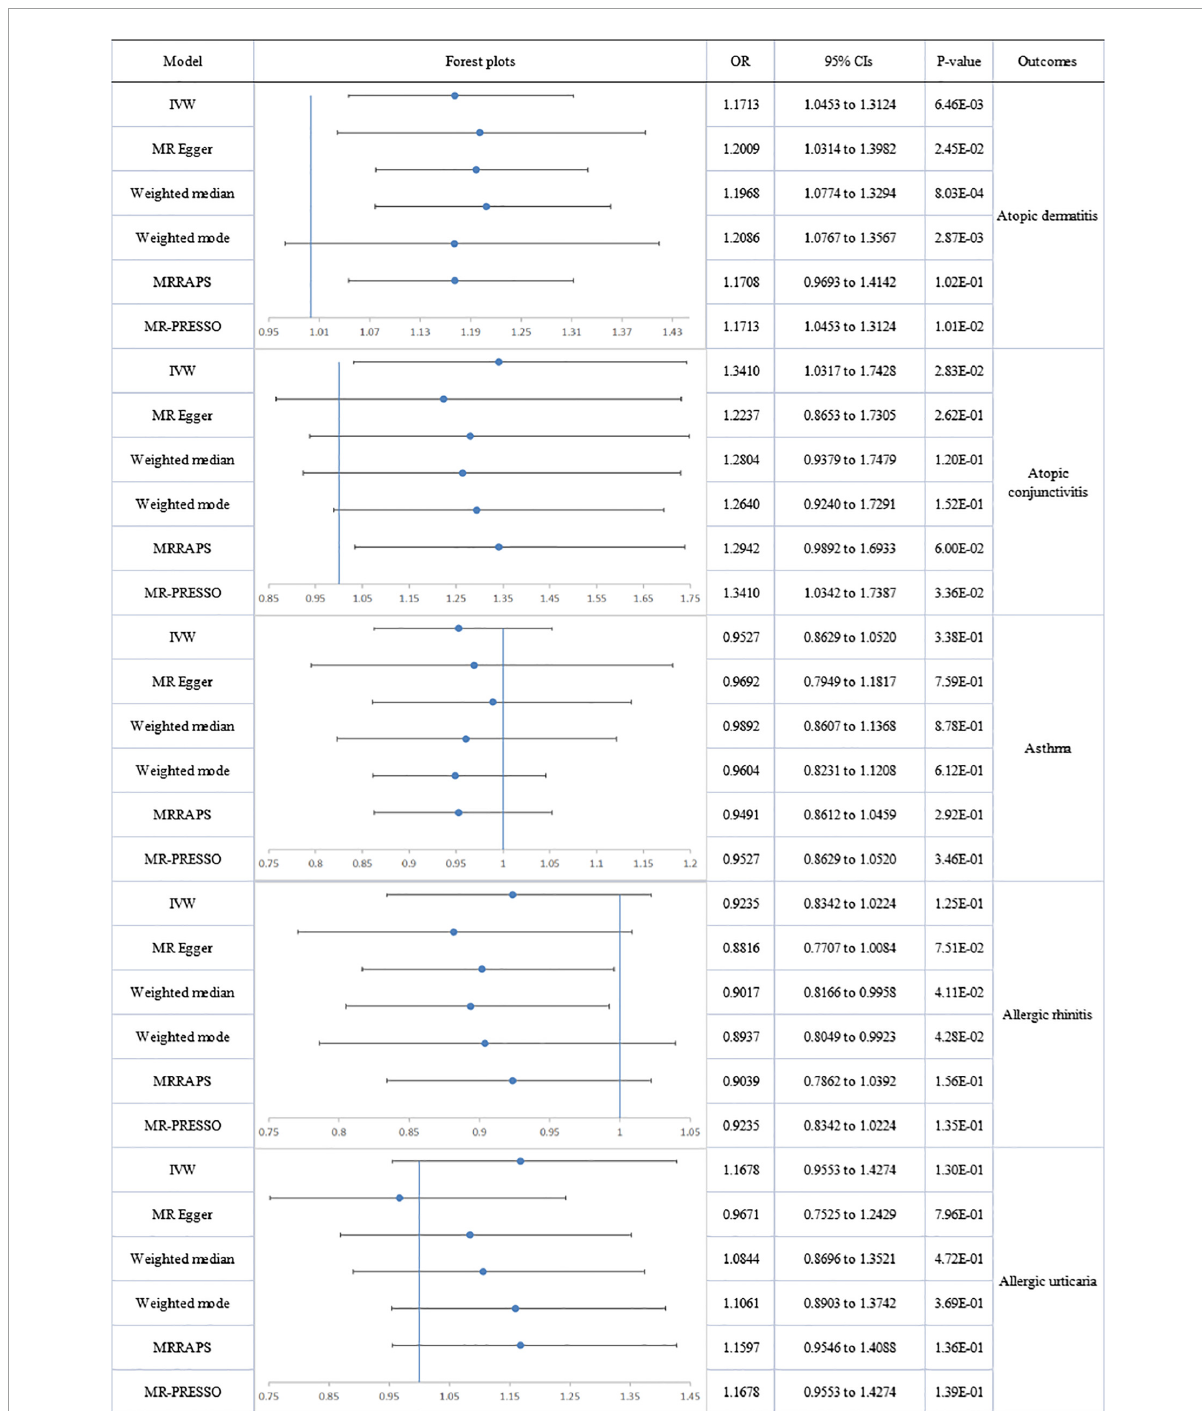
FIGURE5 The forest plot of univariable Mendelian randomization analyses exploring associations between ratio of omega-6 fatty acids and omega-3 fatty acids to allergic diseases risk using different Mendelian randomization statistical models OR: odds ratio; CIs: confidence intervals.